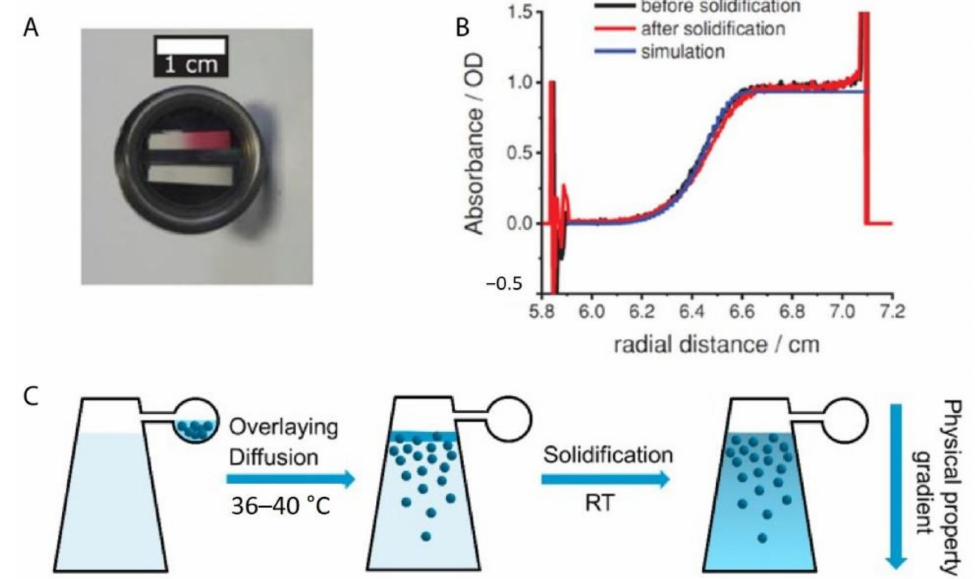
Figure 7. ( A ) Photograph of a piece of gradient nanoparticle superstructure made of spherical gold nanoparticles in gelatin inside an AUC centerpiece. The top sector is the sample sector with the nanoparticle gradient, while the bottom sector is the reference without any nanoparticles inside; ( B ) Absorbance profile of the gold nanoparticle concentration gradient, obtained after the centrifuga- tion at 13,000 rpm for 32 min. The experimental gradient did not change after the solidification and agrees with the simulation results with the SEDFIT; ( C ) Schematic procedures to produce nanoparticle gradient superstructures in the sample sector of an analytical ultracentrifugation band-forming cell by the diffusion at a low angular velocity and subsequent solidification. Reproduced with permission from [98], Copyright Wiley-VCH,